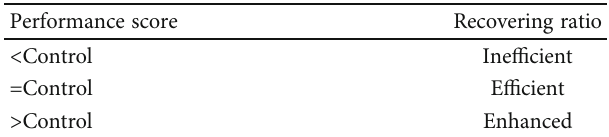
Table 2: Hierarchization score of the protective e ff ect of pharmacological strategies